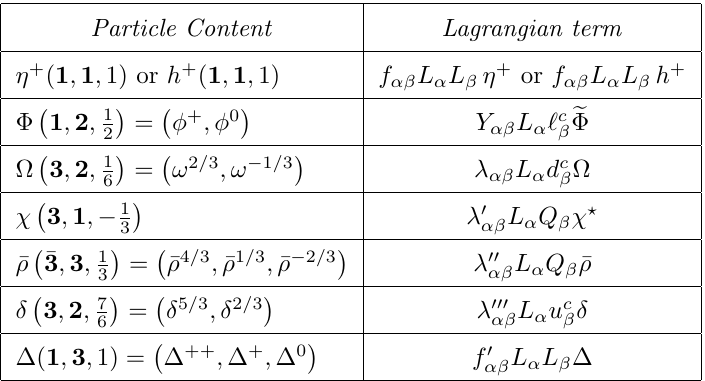
SU(2) L U(1) Y quantum numbers (with (cid:2) (cid:2)